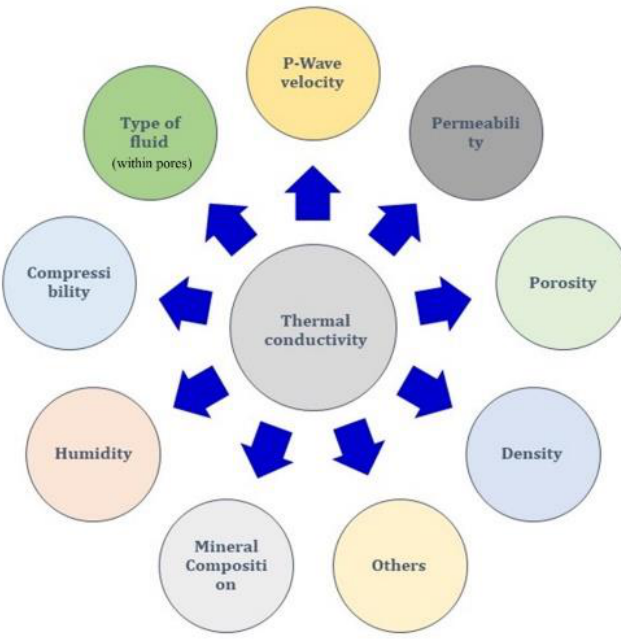
Figure 1. Parameters associated with the thermal conductivity of rocks.